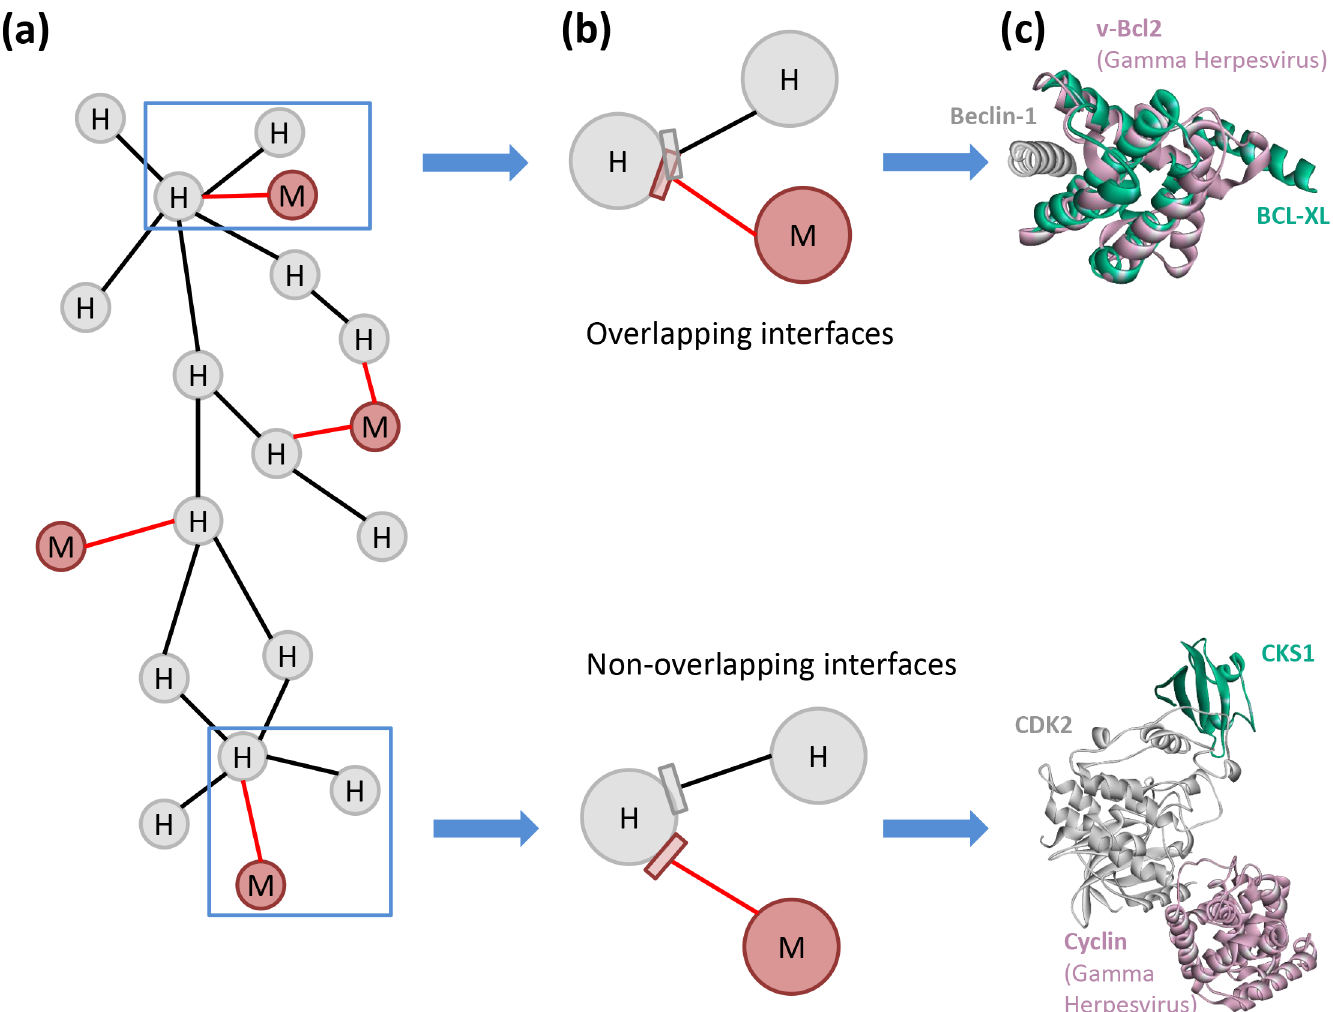
Fig 4. Structural HMI network. (a) High-resolution metaorganism network where grey nodesrepresent host proteins, red nodes microbialproteins, black edgeshost PPIs, and red edges HMIs. If an exogenous interface–HMI–(rededges) overlapsendogenousones, it can abolishthe endogenous PPI. If the exogenous and endogenous interfaces do not overlap,then the HMI does not disrupt the endogenous PPI. Without 3D structure knowledgeof PPIs and HMIs, we cannot infer whetherthe interfaces overlap or not. (b) Zoom-in views of blue boxes show whetherthe interfaces overlap. (c) 3D representations of the interactions shown in part (b). Above diagram shows the superimposed view of 4mi8:AC and 2p1l:AB where Gamma Herpesvirus vBcl2 (red) and humanBcl-XL (green) binds to the same site on humanBeclin-1(grey). Here, an exogenous interface mimics an endogenousinterface. Below diagram shows the superimposed view of 1f5q:AB and 1buh:AB, where Gama Herpesvirus Cyclin (red) and human CKS1 (green) bind to distinct interfaces on humanCDK2